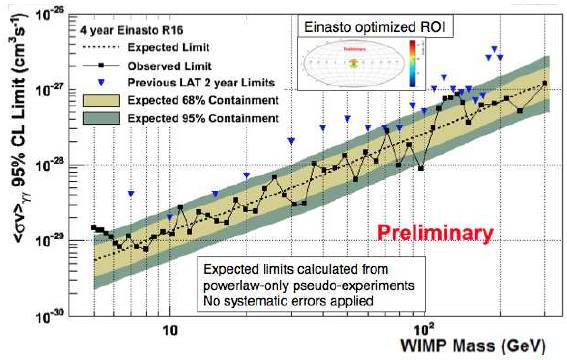
Figure 3: Dark matter annihilation 95% CL cross sec- tion upper limits into γγ for the Einasto profile for a cir- cular region of interest (ROI) with a radius R GC = 16 ◦ centered on the GC with | b | < 5 ◦ and | l | > 6 ◦